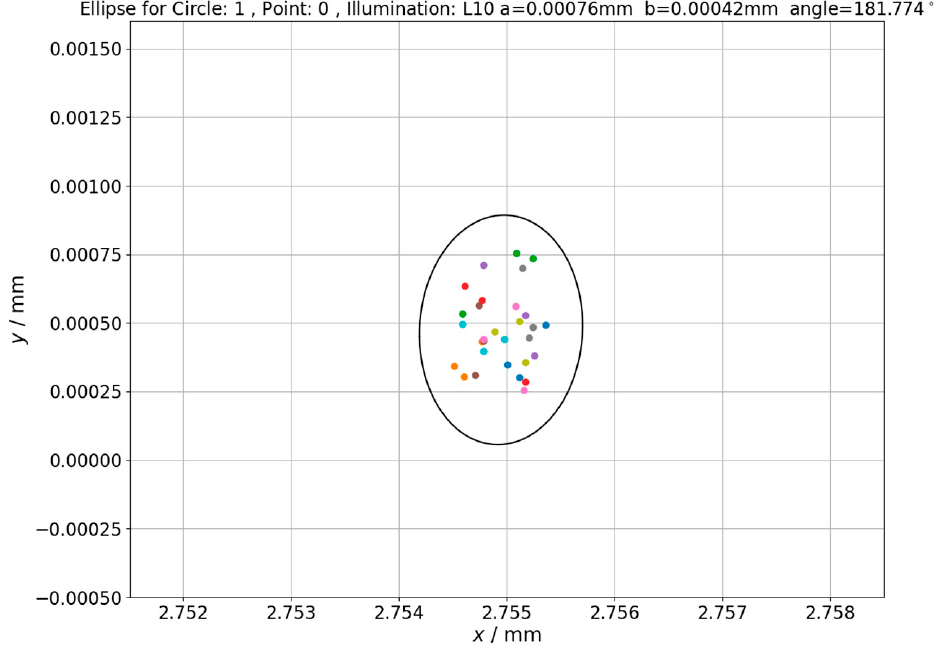
Figure 10. The ellipse of point repeatability obtained for first point in measurement routine. Hole plate standard measurements—Circle 1. Applied illumination L10.